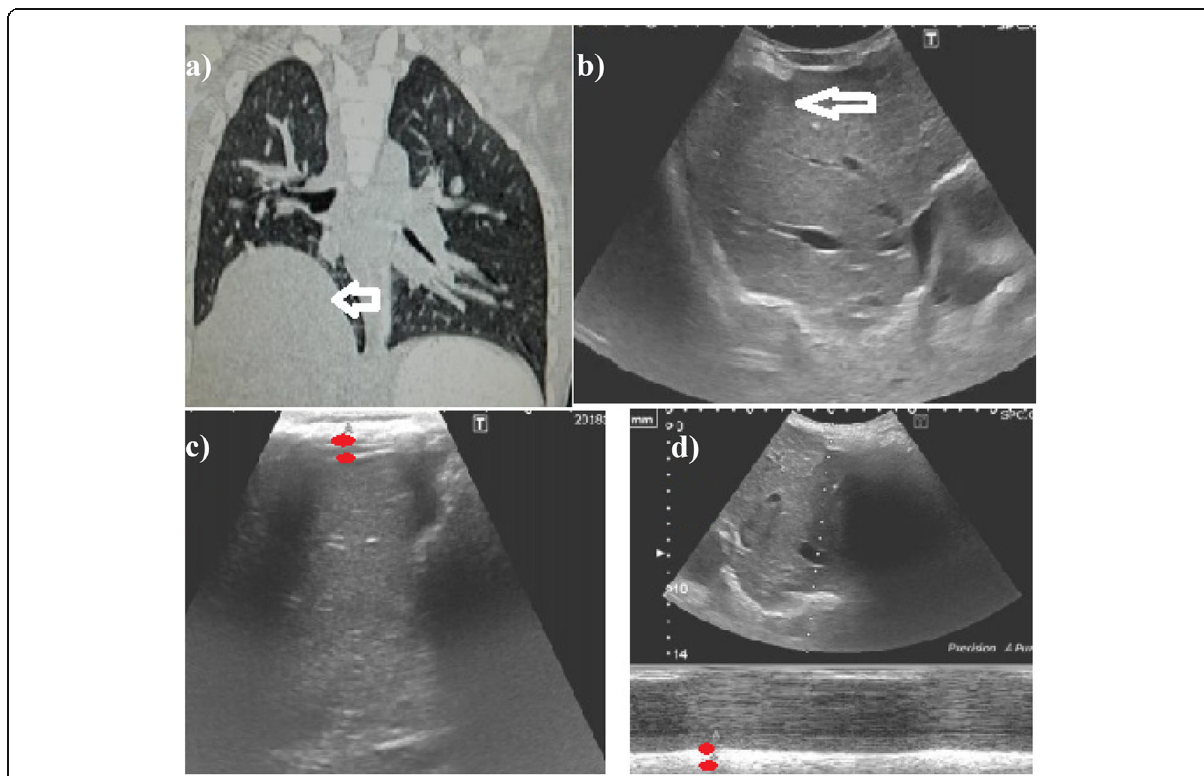
accidentally on chest CT. a Coronal formatted CT of chest (lung window) showing an elevated right diaphragmatic copula (open white arrow) with no mediastinal shift. b An US image — intercostal view — showing abnormal focal bulge of the anteromedial aspect of the right hemidiaphragm (open white arrow) with no defect detected. c US image using superficial probe through an intercostal view showing abnormal focal thinning out of the right hemidiaphragm (1.7 mm between the red dots) with a thickening fraction 22%. d US image in intercostal view showing limited diaphragmatic movements in normal breathing = 0.8 cm, deep breathing = 1.8 cm, and in sniff test = 1 cm between the red dots in d ; these findings were relevant to a right hemidiaphragmatic eventration (a dromedary hump) with